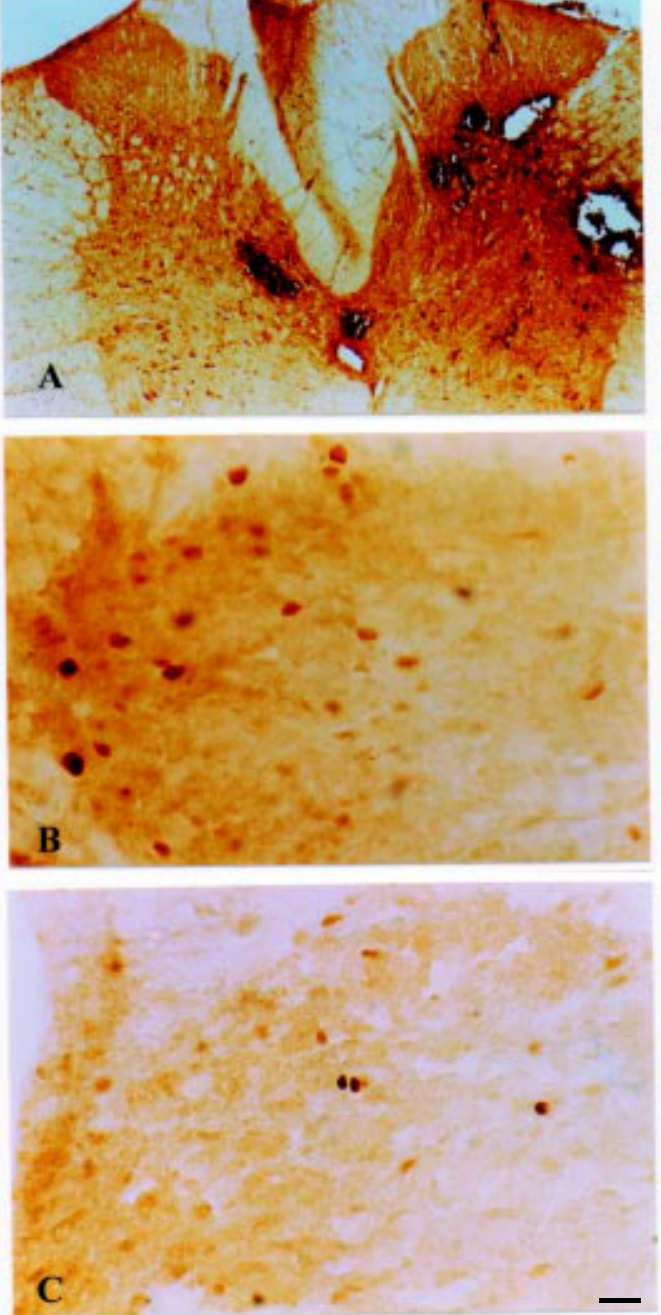
Figure 1 - Expression of Fos protein detected by immunocytochemistry in the thoracic segment of the spinal cord and in midbrain structures. A , Fos expression detected at the lumbar segment level in group 3 animals (contusion). B , Fos expression detected in laminae I and II of the lumbar spinal cord in group 3 animals (contusion); detail of a sensory dorsal horn. C , Fos expression detected in laminae I and II of the lumbar spinal cord in group 2 animals (laminectomy); detail of the sensory dorsal horn. ( A , Bar = 200 µm; B , C, bar = 100